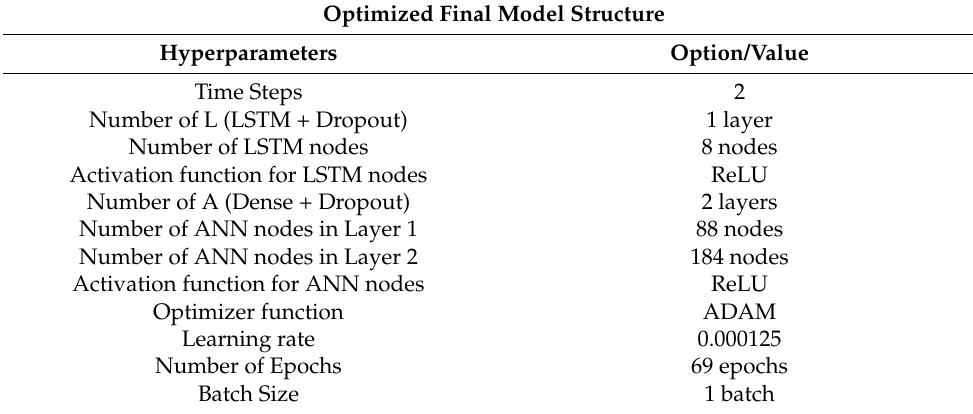
Table 4. Optimized hyperparameters for the final LSTM-ANN model